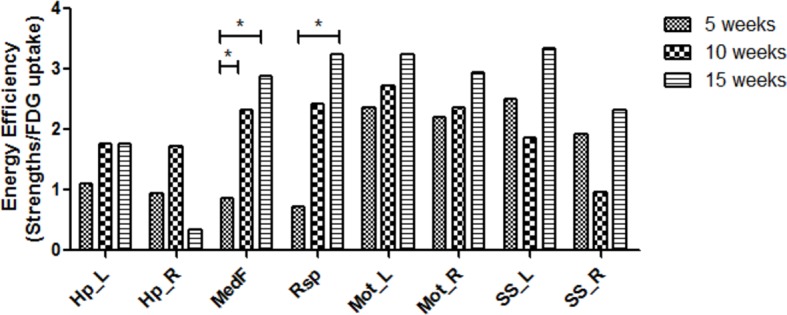
Increased energy efficiency in the medial prefrontal and retrosplenial cortices during maturation.Energy efficiency defined as a ratio of metabolic connectivity strength to normalized FDG uptake was estimated for each region. The energy efficiency changes and was interpreted to be reorganized during brain maturation. While efficiency in the midline structure was lower at 5 week of age, that is, medial prefrontal and retrosplenial cortices, but increased significantly in 10 and 15 weeks. (*p < 0.05 based on Bonferroni correction over permutation test). FDG, 18F-Fluorodeoxyglucose.DOI:
http://dx.doi.org/10.7554/eLife.11571.013
10.7554/eLife.11571.014Figure 4—source data 1.Energy efficiency of each brain region.